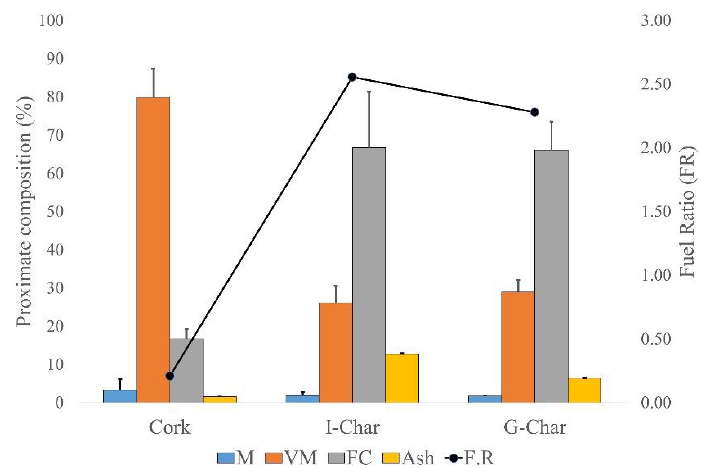
Figure 7. The proximate composition (M: moisture, VM: volatile matter, FC: fixed carbon, Ash: inorganic matter), and the fuel ratio (F.R) of cork and cork biochars.